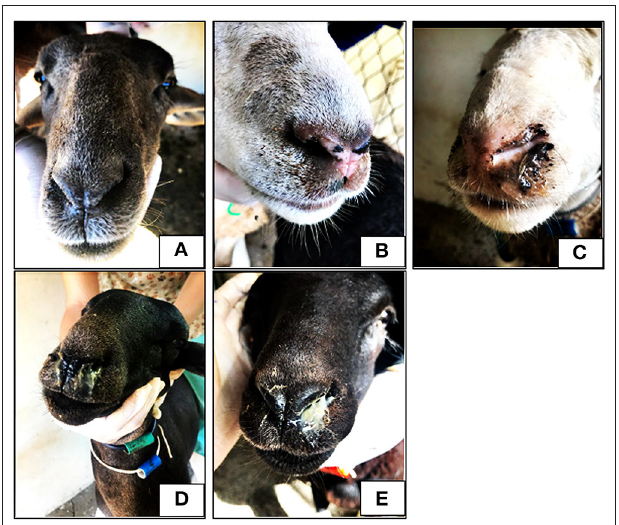
FIGURE 1 | Photos of lambs with different nasal discharge score. No discharge (A) , serous discharge (B) , sero-mucous discharge (C) , thick mucous discharge (D) and mucopurulent thick discharge (E)